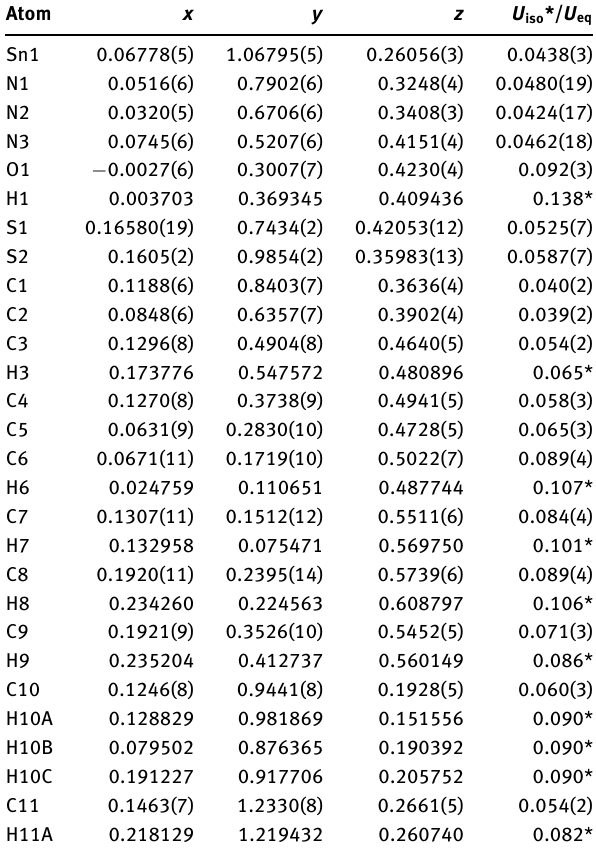
Table 2: Fractional atomic coordinates and isotropic or equivalent isotropic displacement parameters (Å 2